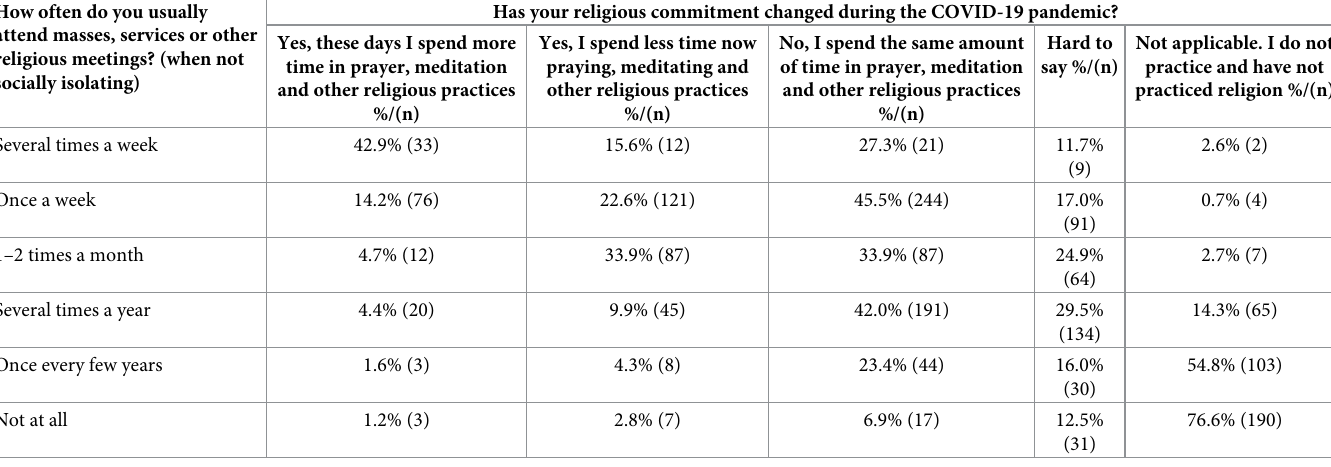
Has your religious commitment changed during the COVID-19